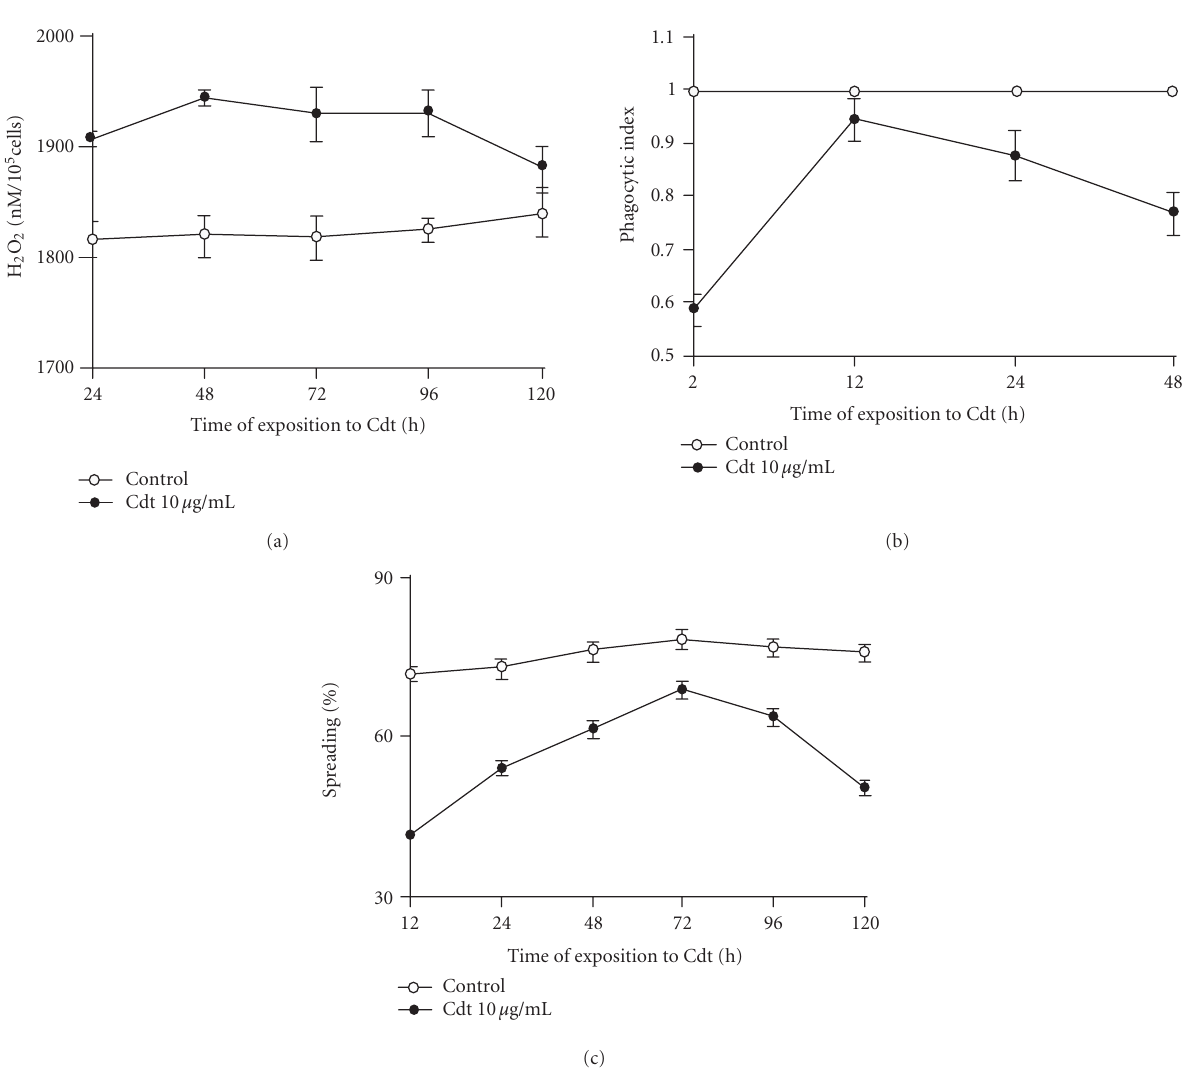
Figure 3. Functional status of macrophages. Peritoneal macrophages were obtained and exposed in vitro to 10 µ g/mL of Cdt for di ff erent times as described in “materials and methods.” The activation of the cultured peritoneal macrophages was determined by measuring the oxygen intermediates metabolites (H 2 O 2 ). The phagocytic index and percentage spreading were determined as described above. Each point represents the mean value of samples from five experiments in di ff erent groups of five mice. Statistical di ff erences between the treatments were P > .